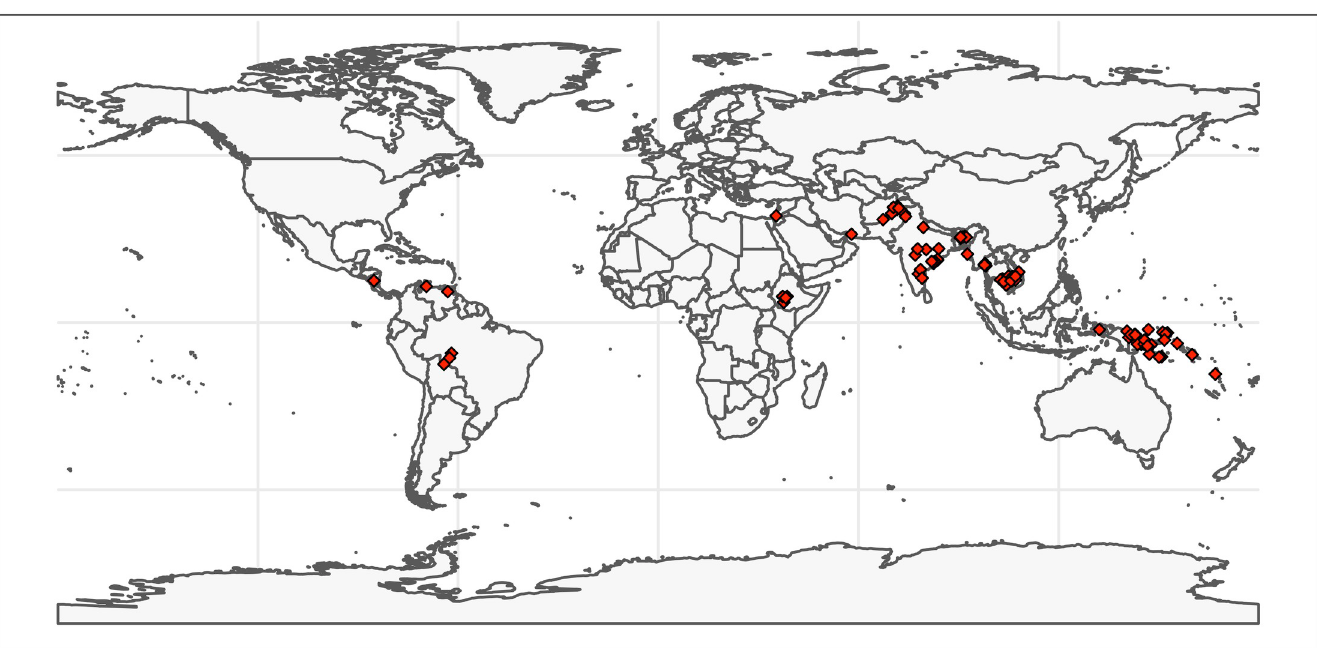
Fig 2. Location of the studies. Made with Natural Earth (https://www.naturalearthdata.com/ and downloaded using the R package rnaturalearth.